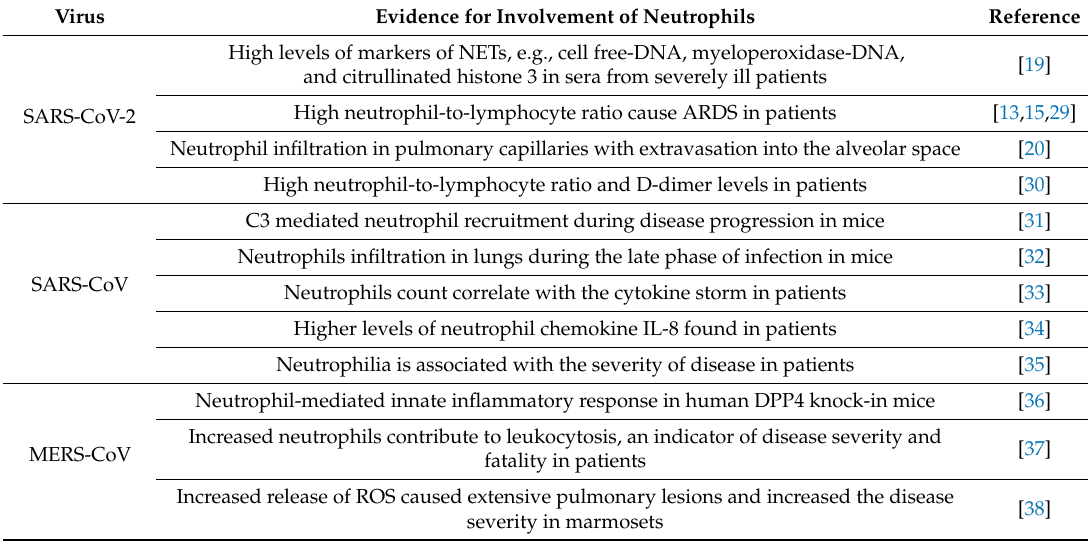
Table 1. Evidence for neutrophil-mediated necroinflammation in coronavirus infections. Virus Evidence for Involvement of